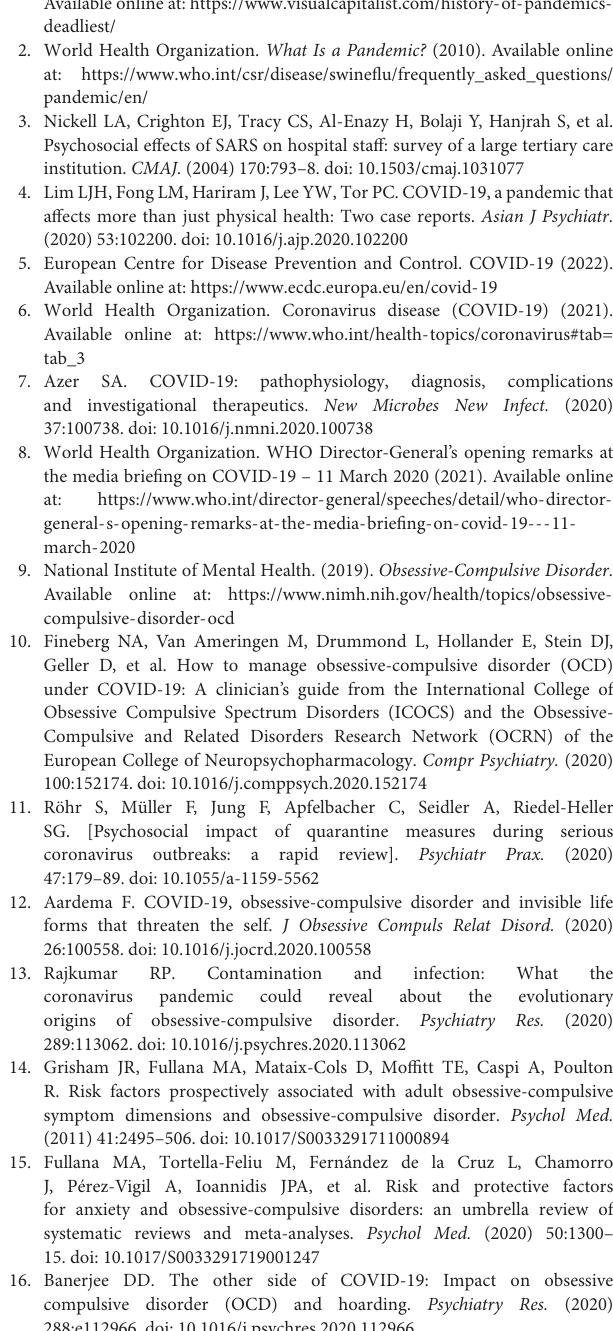
tab_3 7. Azer SA. COVID-19: pathophysiology, diagnosis,